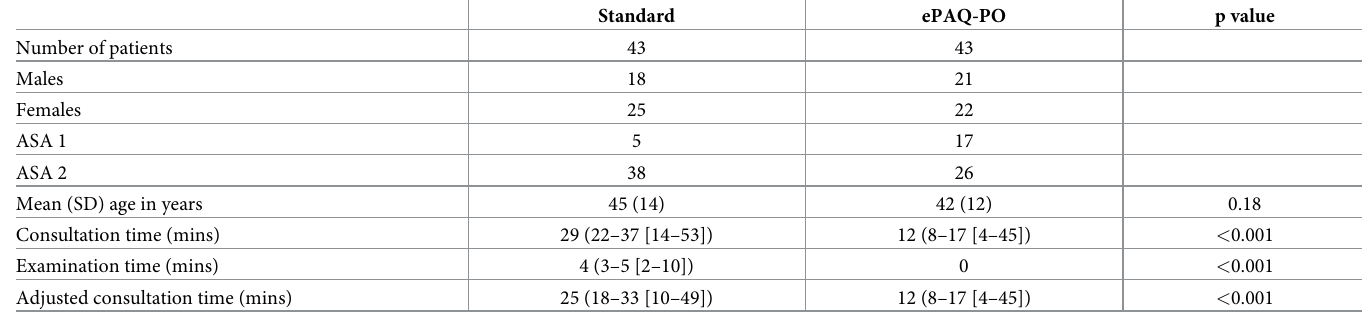
Table 1. Demographic data and results for standard vs ePAQ-PO groups. Times are median (IQR [min-max]) values. Adjusted consultation time = measured consulta- tion time—examination